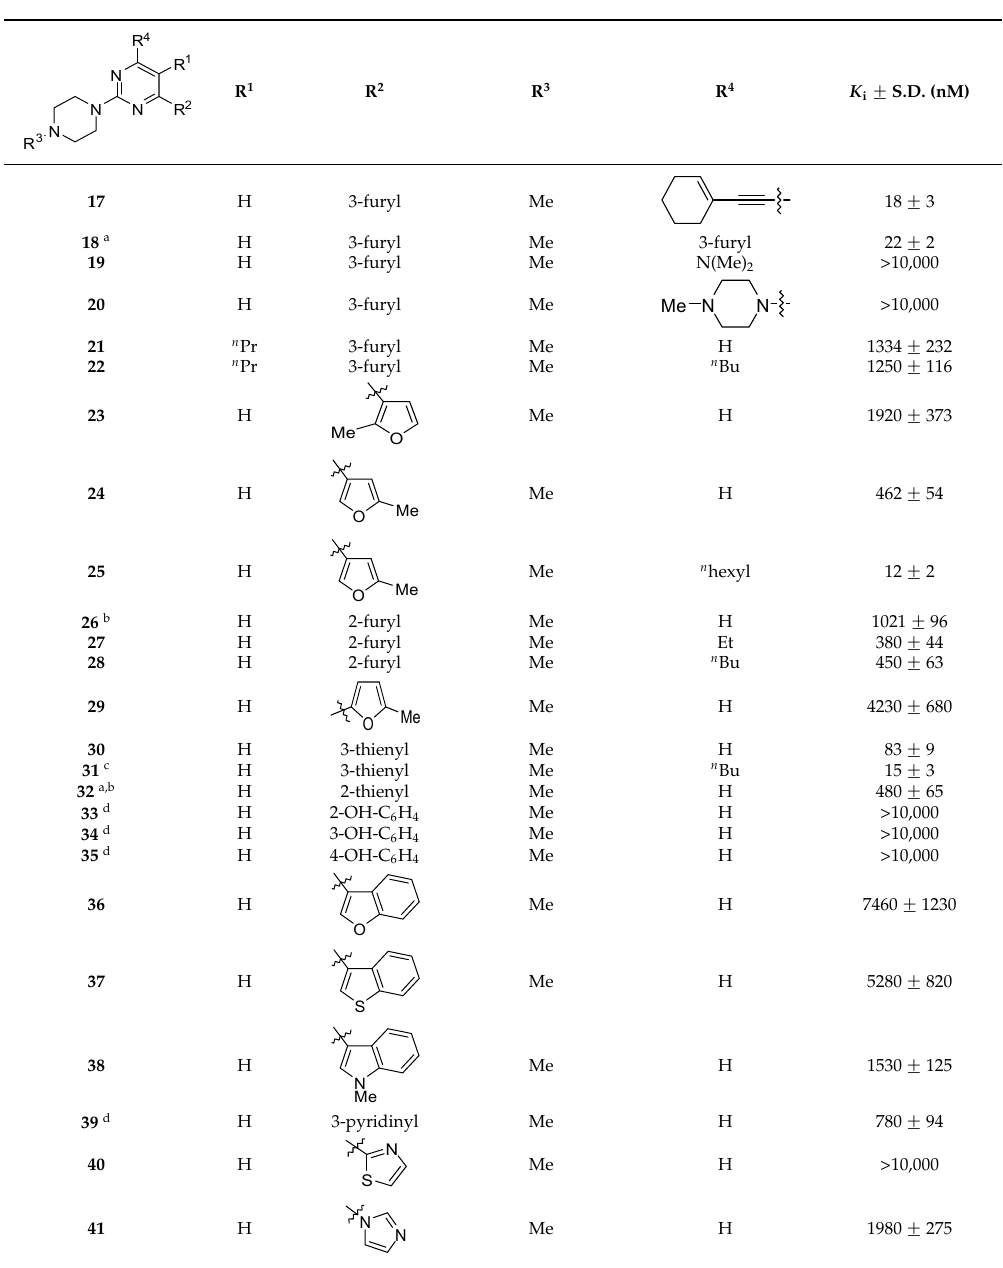
Table 1. Cont . Table 1. 5-HT 7 binding affinities of pyrimidine derivatives 1 – 41 .